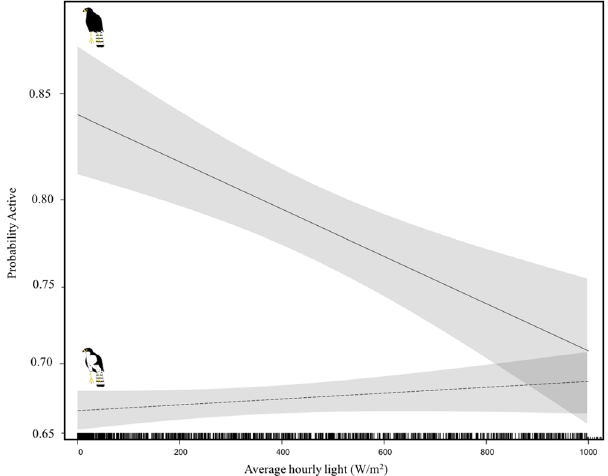
Figure 1. Foraging activity (measured as presence or absence from the core nesting area (10% kernel estimate) of black sparrowhawks on the Cape Peninsula across the ambient light spectrum with 95% confidence intervals. During the breeding season, we found a significant interaction between light level (W/m 2 ) and morph ( χ 2 1 = 18.2, P = 0.01). Controlling for breeding stage, for white morph birds, foraging activity increased slightly as conditions became brighter (P = 0.8), whereas activity levels for dark morphs declined substantially and significantly as light levels increased (P < 0.001). Examining this relationship in more detail, dark morphs remain more active below around 800 W/m 2 , in conditions brighter than this there was little difference in activity levels away from the nest between the two morphs, as can be seen from the overlapping confidence limits. “Morph images” by Ann